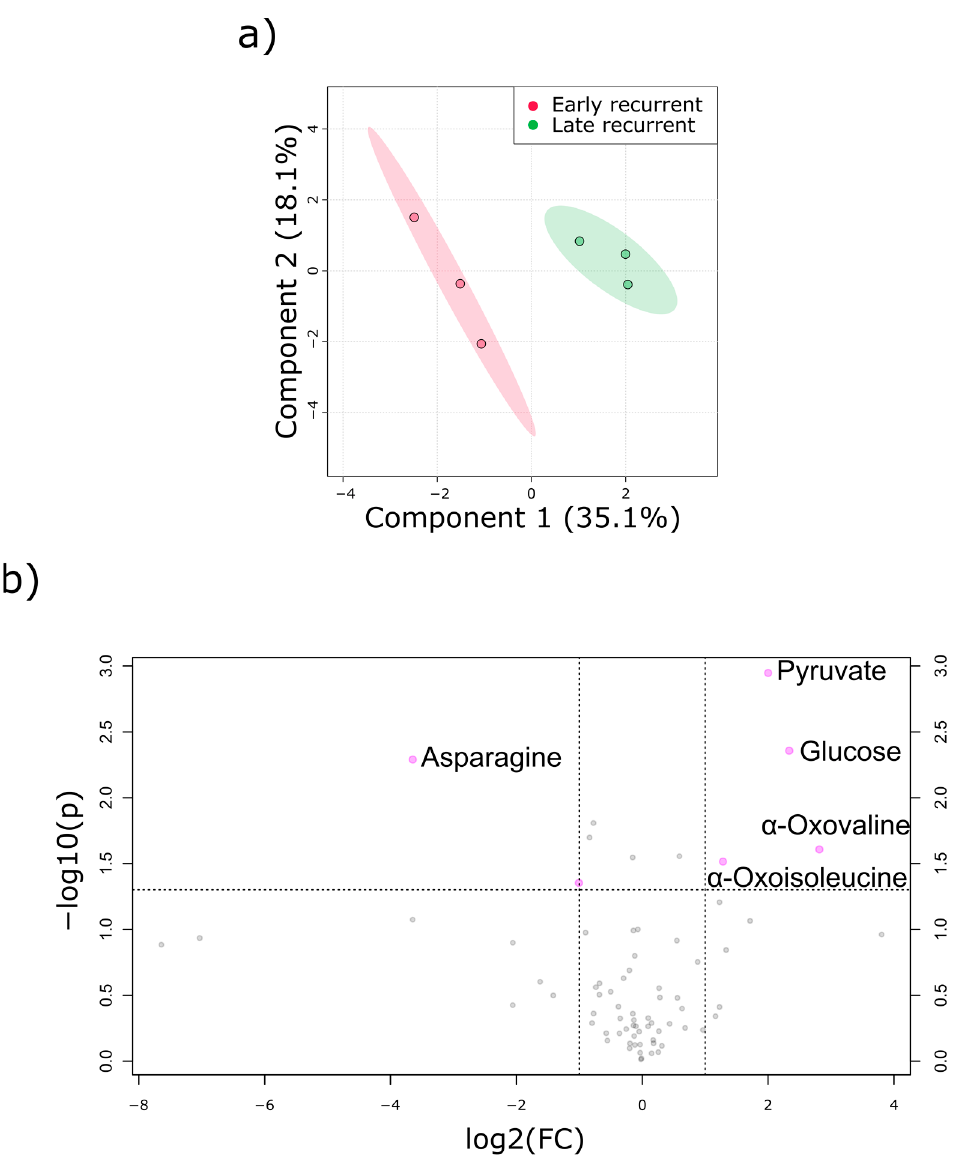
Figure 4. Exometabolome analysis of PDAC derived PDOs. ( a ) PLS-DA revealed discrimination between metabolites excreted from early recurrent PDOs (red) and late recurrent PDOs (green). ( b ) Volcano plot analysis of extracellular metabolites. Early recurrent to late recurrent fold changes are displayed as log2 values. Only top five metabolites are labeled. Each data point represents at least three technical replicates of the different PDOs.